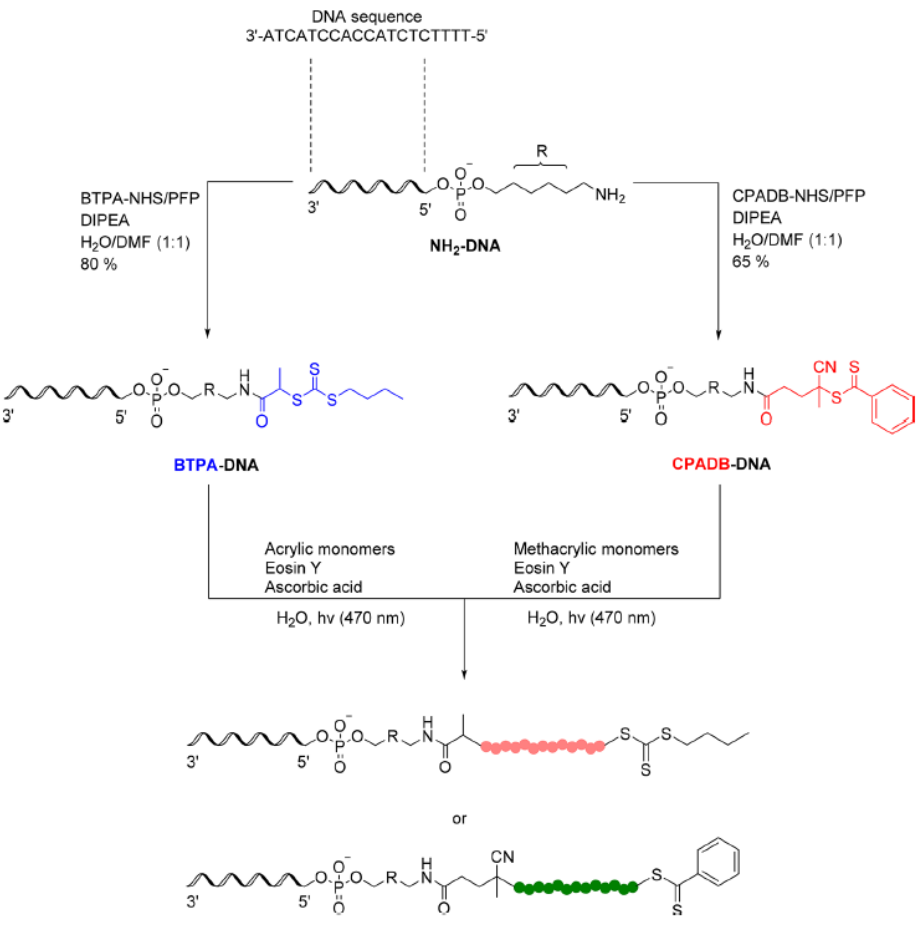
Figure 17. PET-RAFT grafting-from approach from DNA. Reproduced with permission from ref. [104].